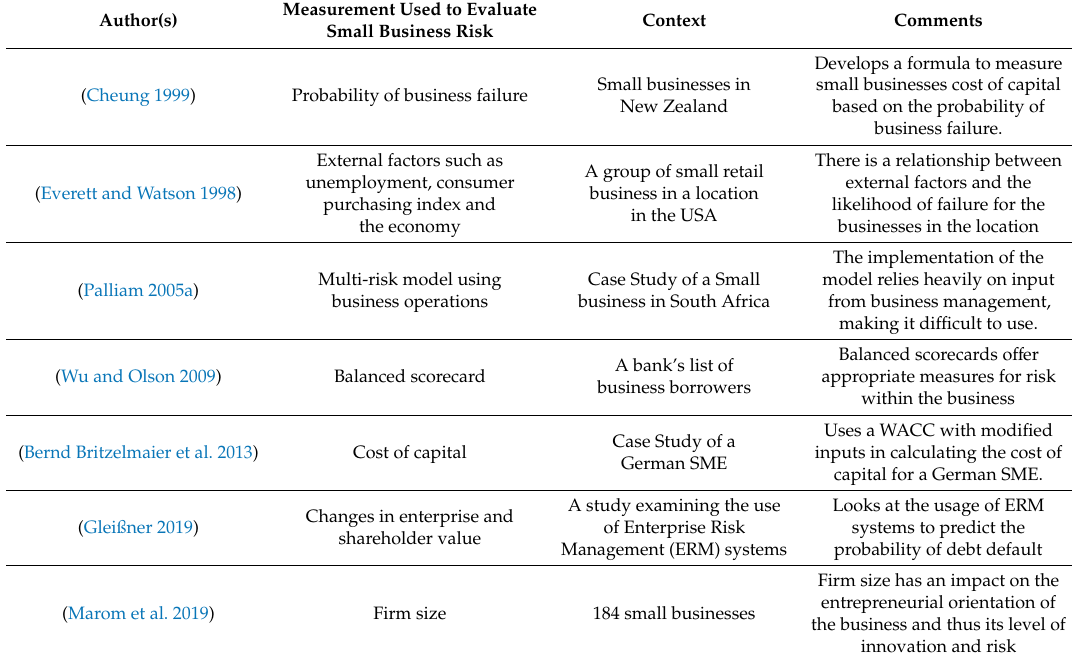
Table 3. Measurement of small business risk used in the